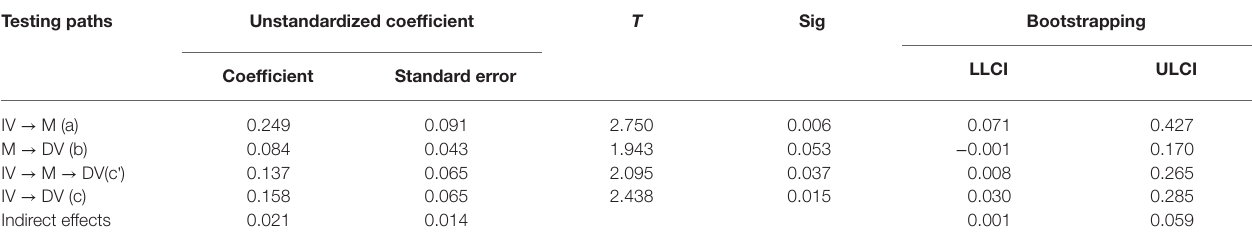
TABLE 3 | Coefficient and bootstrapping for the mediation. Testing paths Unstandardized coefficient T Sig Bootstrapping